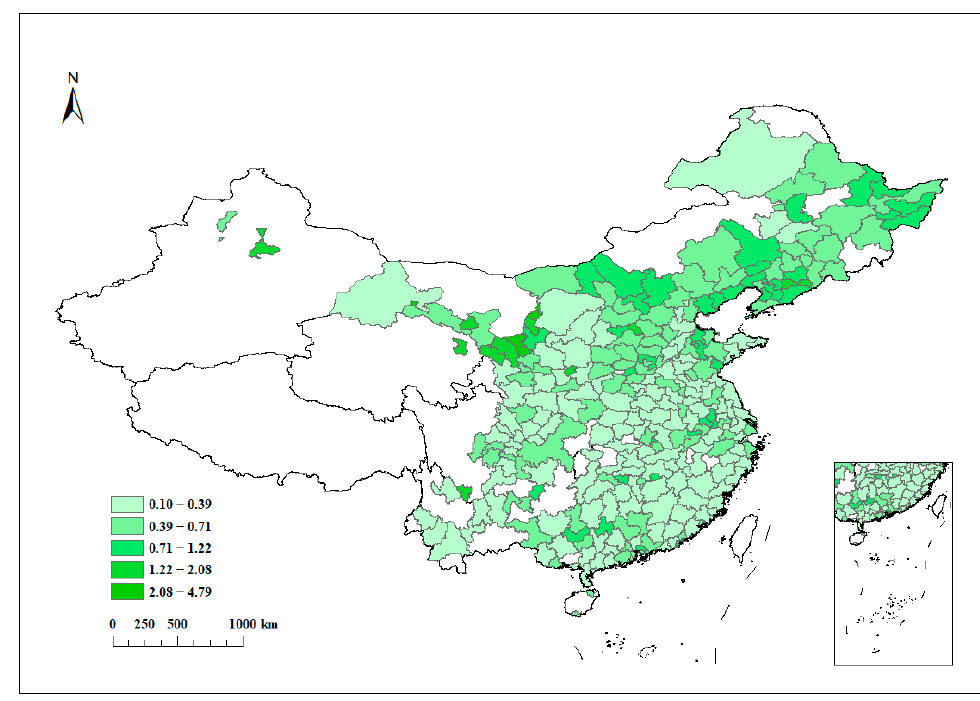
Figure 1. Average carbon emission intensity in 2006–2019.